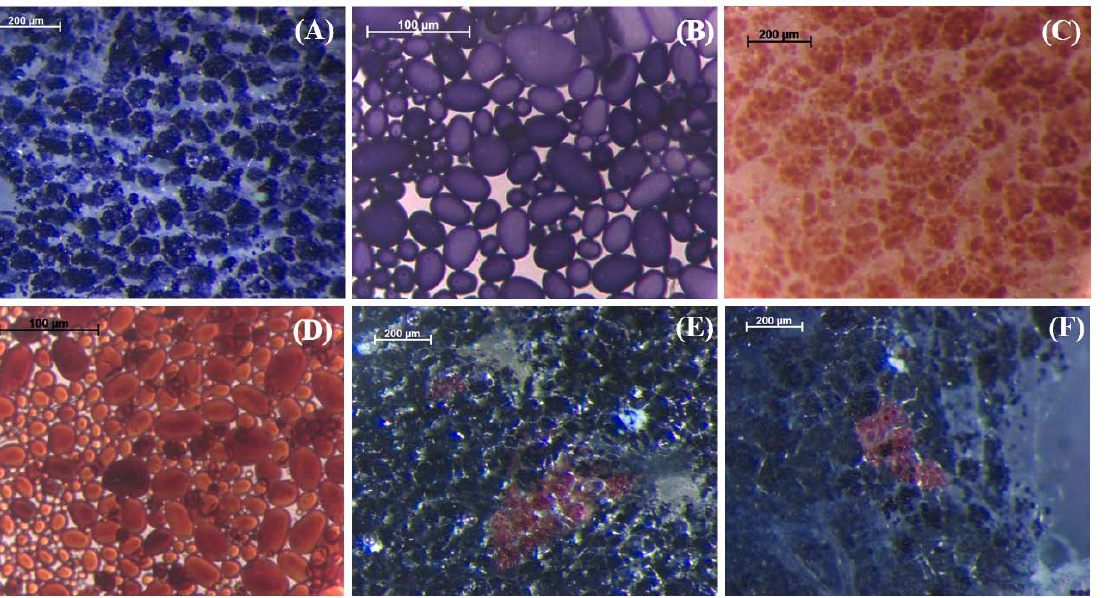
Figure 2. Examples of the different phenotypes detected via the histochemical Lugol-Iodine staining of microtuber sections. WT : wild-type (Yukon Gold, strain TXYG79) tuber showing typical blue staining of starch indicative of normal amylose/amylopectin ratio; T1-27 : wherein Target site 1 was targeted for mutation, showing small sectors of complete knockout phenotype surrounded by largely blue-colored tuber section; T1-32 : wherein Target site 1 was targeted for mutation, but does not show the knockout phenotype; T2-7 : wherein Target site 2 was targeted for mutation showing complete knockout phenotype, i.e., reddish-brown-colored staining throughout the tuber section due to the absence of amylose.